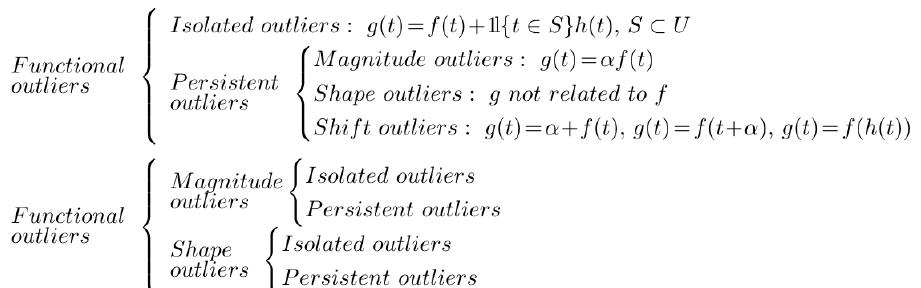
Figure 1. Functional outlier taxonomies. Bottom: standard taxonomy. Top: the taxonomy as introduced by Hubert et al. Reprinted by permission from Springer Nature: Springer, Statistical Methods & Applications, Discussion of “Multivariate functional outlier detection”, Arribas-Gil Ana, Romo Juan, Copyright